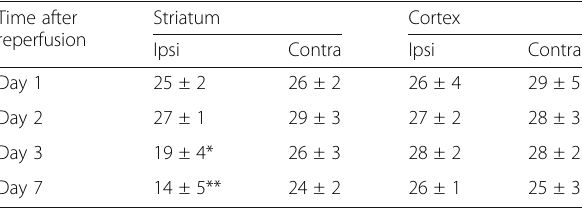
Table 1 Temporal changes in Nissl-stained cells in the striatum and cortex after mild focal ischemia